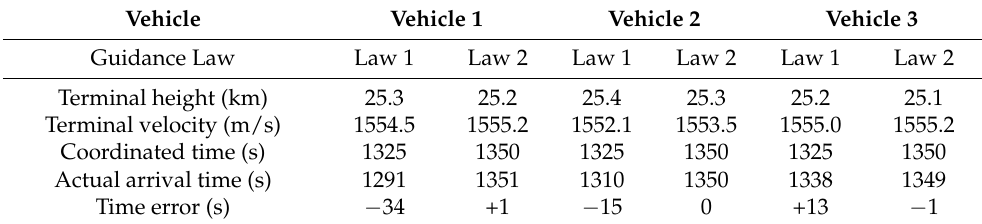
Table 4. Terminal states of time cooperative guidance Law 1 and Law